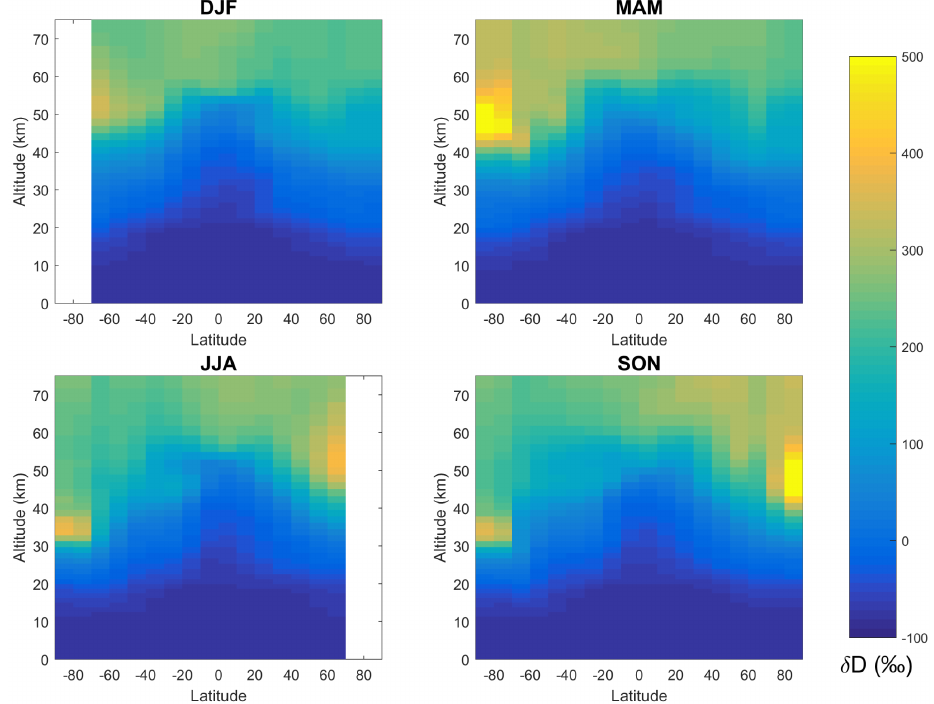
Figure 7. δ D by season from the ACE-sampled WACCM data